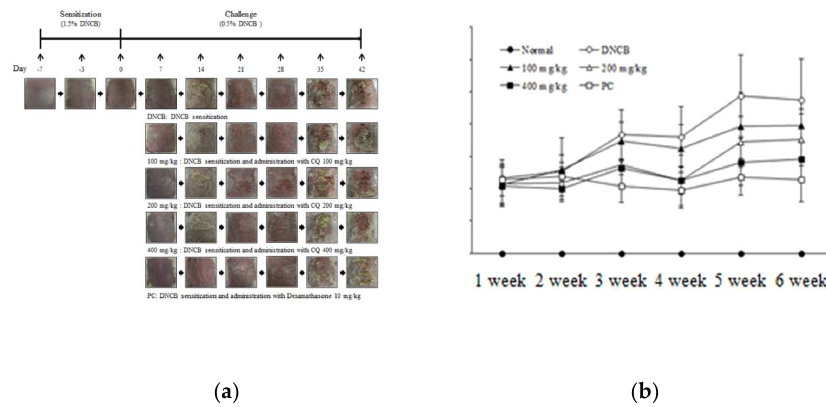
Figure 3. The severity on dorsal skin lesions in DNCB-induced BALB/c mice. ( a ) To demonstrate the effect of CQ in DNCB-induced BALB/c mice, clinical assessment of the dorsal skin lesions was performed once a week. The mice were randomly divided into six groups: normal, DNCB, and DNCB + CQ (100, 200, and 400 mg/kg) and DNCB + PC 10 mg/kg for 6 weeks; ( b ) The dermatitis score including erythema, dryness, edema, and erosion was calculated once a week.